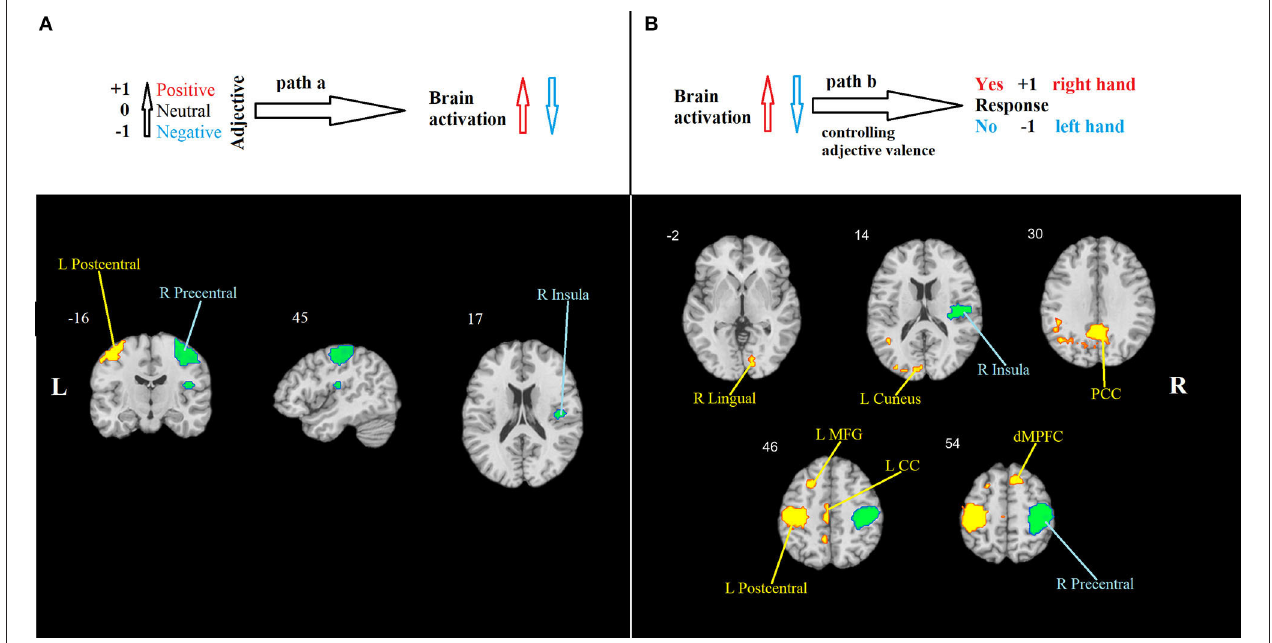
FIGURE 2 | Mediation analysis results. (A) Path a : brain regions that are significantly associated with adjective valence. Hot colors show the region (the left primary somatosensory cortex) in which activity increases in response to positive valence, indicating the propensity to respond “Yes” using the right-hand button. Cool colors show regions in which activity increases in response to negative valence. They include the right primary motor cortex, indicating the propensity to respond “No” using the left-hand button, and the right insula. (B) Path b : brain regions that are significantly associated with behavioral response, controlling for adjective valence. Hot colors show regions in which activity increases when the response “Yes” is chosen, and cool colors show regions that increase their activity when the response “No” is chosen. PCC, posterior cingulate cortex; LMFG, left middle frontal gyrus; LCC, left cingulate cortex; dMPFC, dorsal medial prefrontal cortex. All effects are significant at p < 0.001,